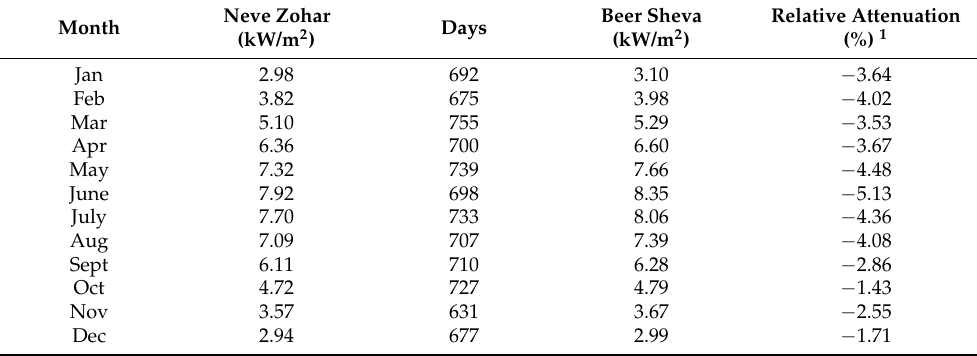
Table 1. Monthly average daily % relative attenuation of global irradiation intensities (kW/m 2 ). Neve Zohar Month (kW/m 2 )